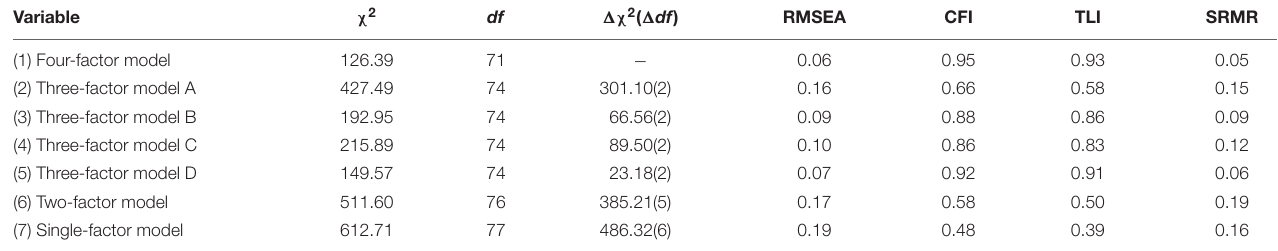
TABLE 3 | Model fit results for confirmatory factor analyses (Study 2). Variable χ 2 df